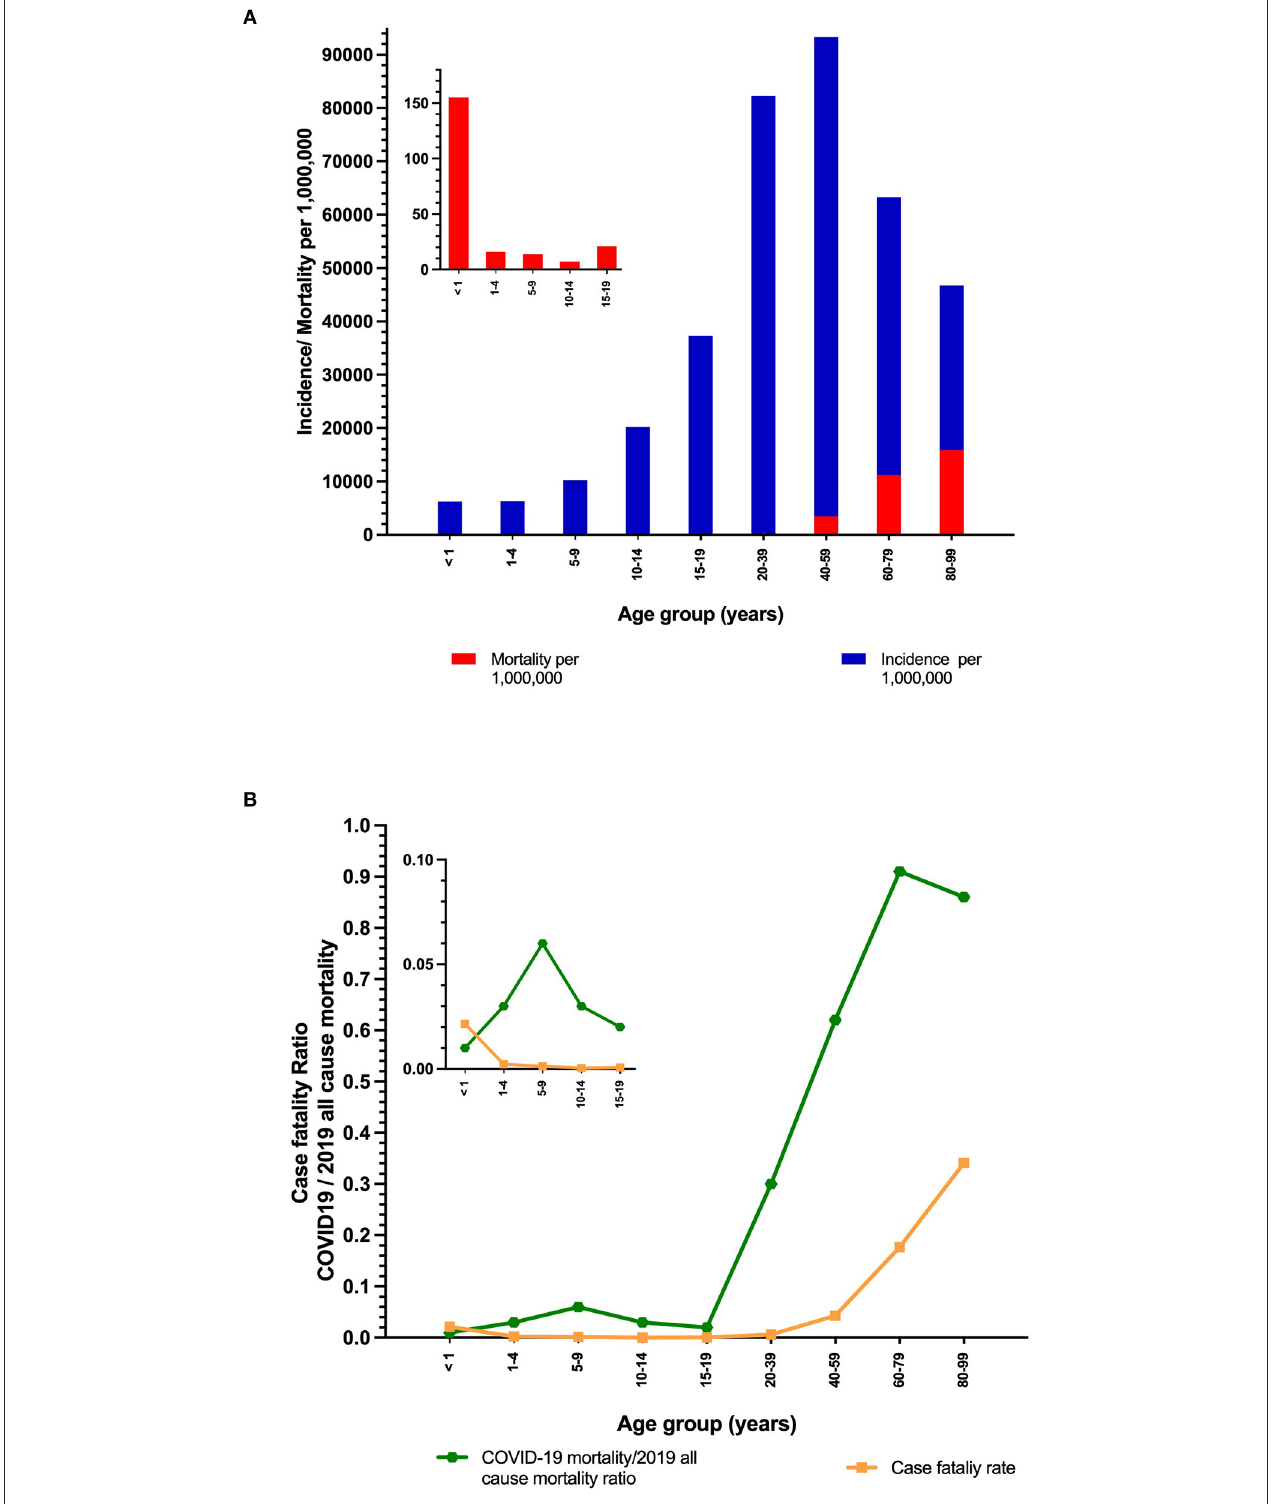
FIGURE 1 | (A) COVID-19 annualized incidence and mortality rates per 1,000,000 people (B) case-fatality rate, and COVID-19/ 2019 all-cause mortality ratio by age strata.